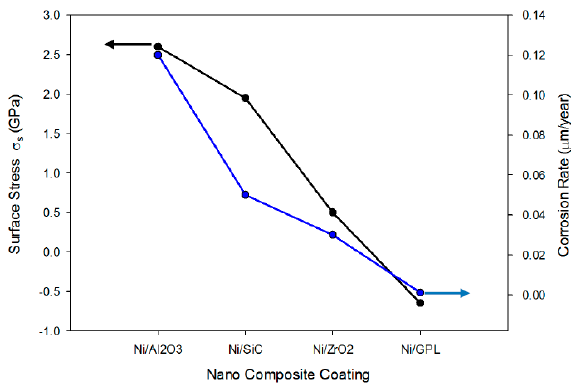
Figure 4. Surface Stresses and Corrosion rate of different nanocomposite coatings.